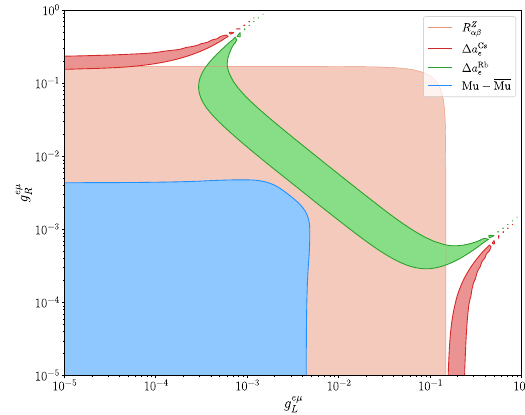
Fig. 5 Constraints on g e the left, allowed regions in the same-sign ( g e agreement with the experimental bounds on LFU Z decay ratios (light